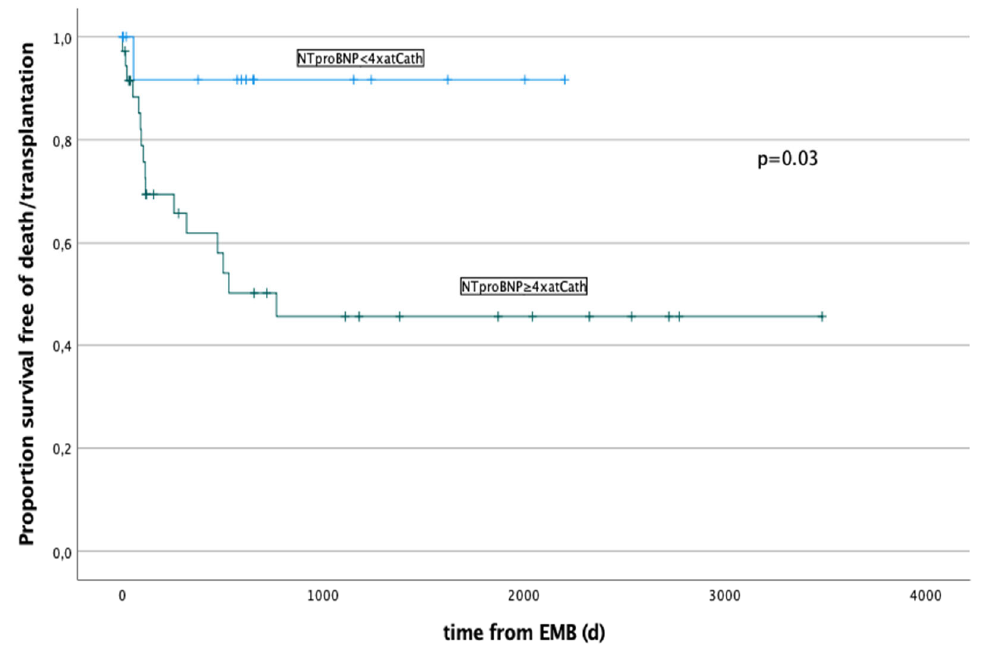
Figure 2. Survival function in relation to the maximal level of NT-pro-BNP prior to RV-EMB. Patients with a NT-pro-BNP ≥ 4 × the normal value have a significantly increased risk ( p = 0.03) for a negative outcome: death or cardiac transplant occurred in a total of 13/27 (48%).